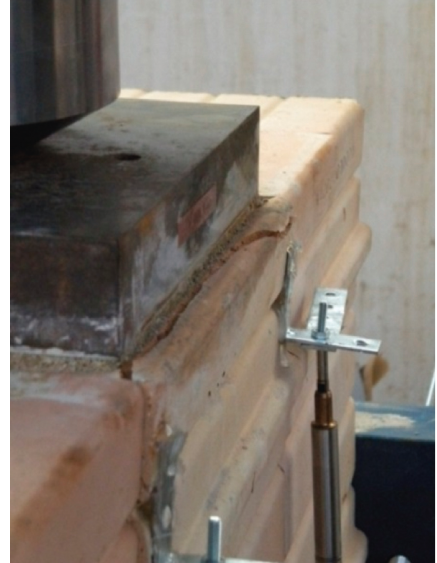
Figure 9: First specimen failure under the maximum